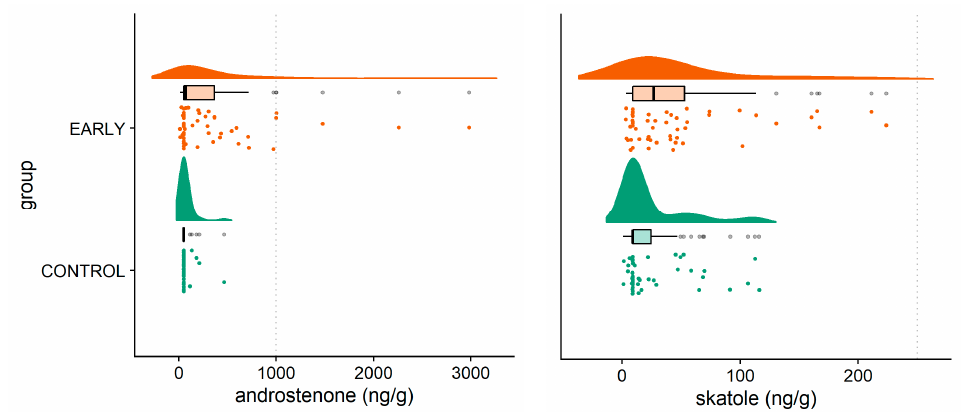
Figure 1. Distribution of androstenone ( left ) and skatole ( right ) concentrations as measured in the shoulder fat (SF) according to the immunization scheme.